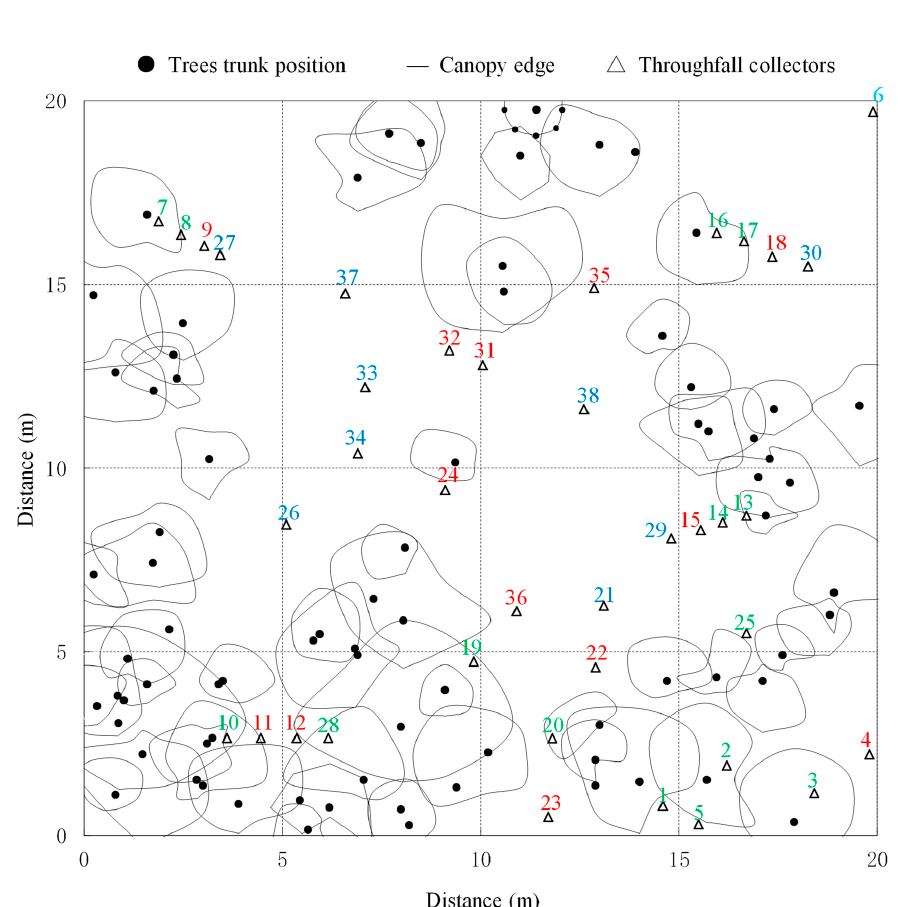
Figure 1. Map of the experimental plot (20 × 20 m) showing the locations of trees and collectors. The Arabic numerals represent the serial number of throughfall collectors, green means the collector is located in the inner canopy, red means the collector is located in the canopy periphery, and blue means the collector is located beneath gaps.